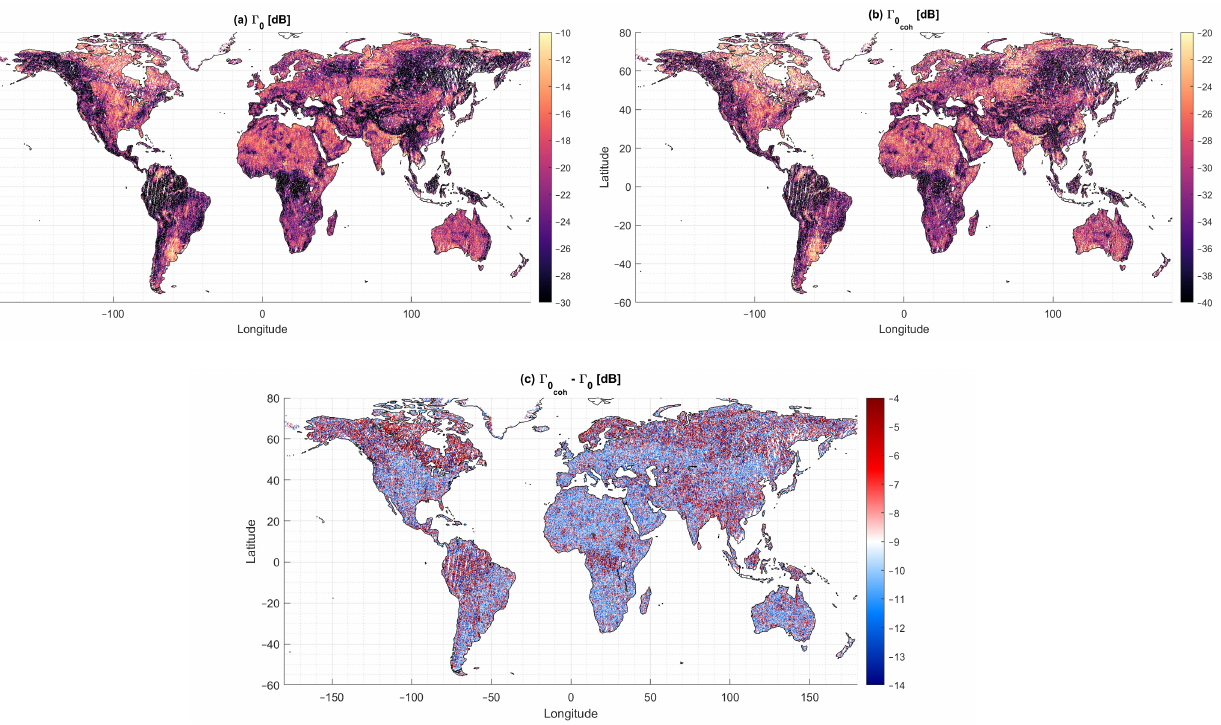
Figure 1. ( a ) Total power waveform reflectivity, ( b ) Coherent component reflectivity about 10 dB smaller than the total power waveform, and ( c ) difference between ( a , b ).